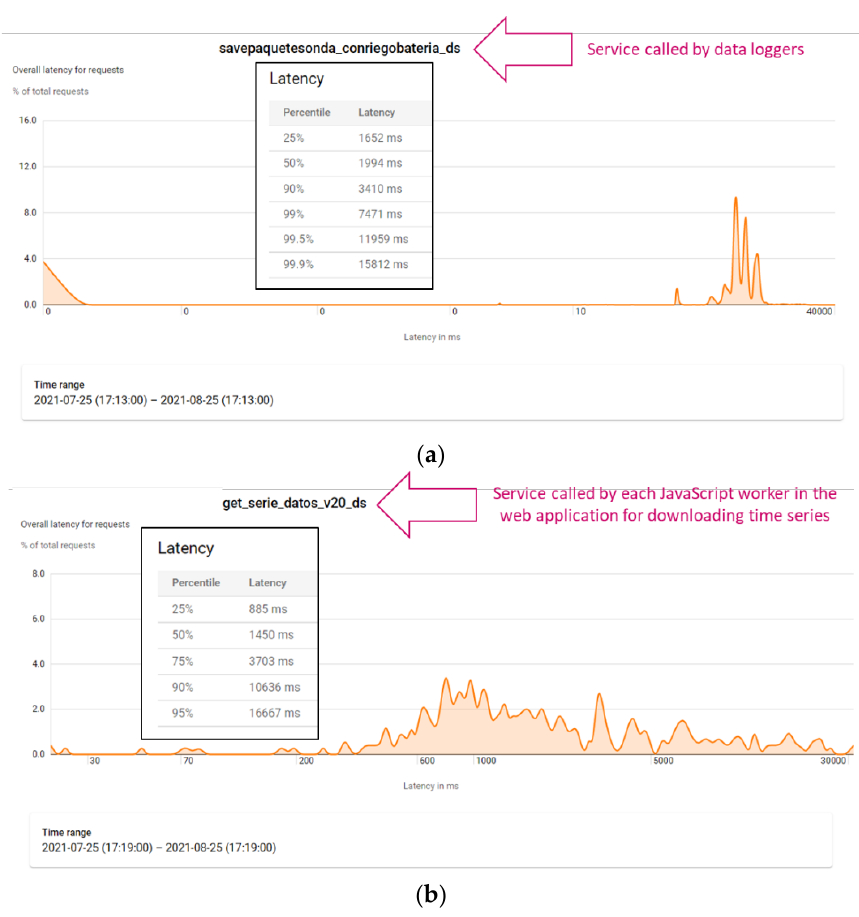
Figure 13. Distribution of the overall latency for request for the main used services. ( a ) Latency distribution for the service utilised by data loggers. ( b ) Latency distribution for the service used by each JavaScript worker in the WEB application.